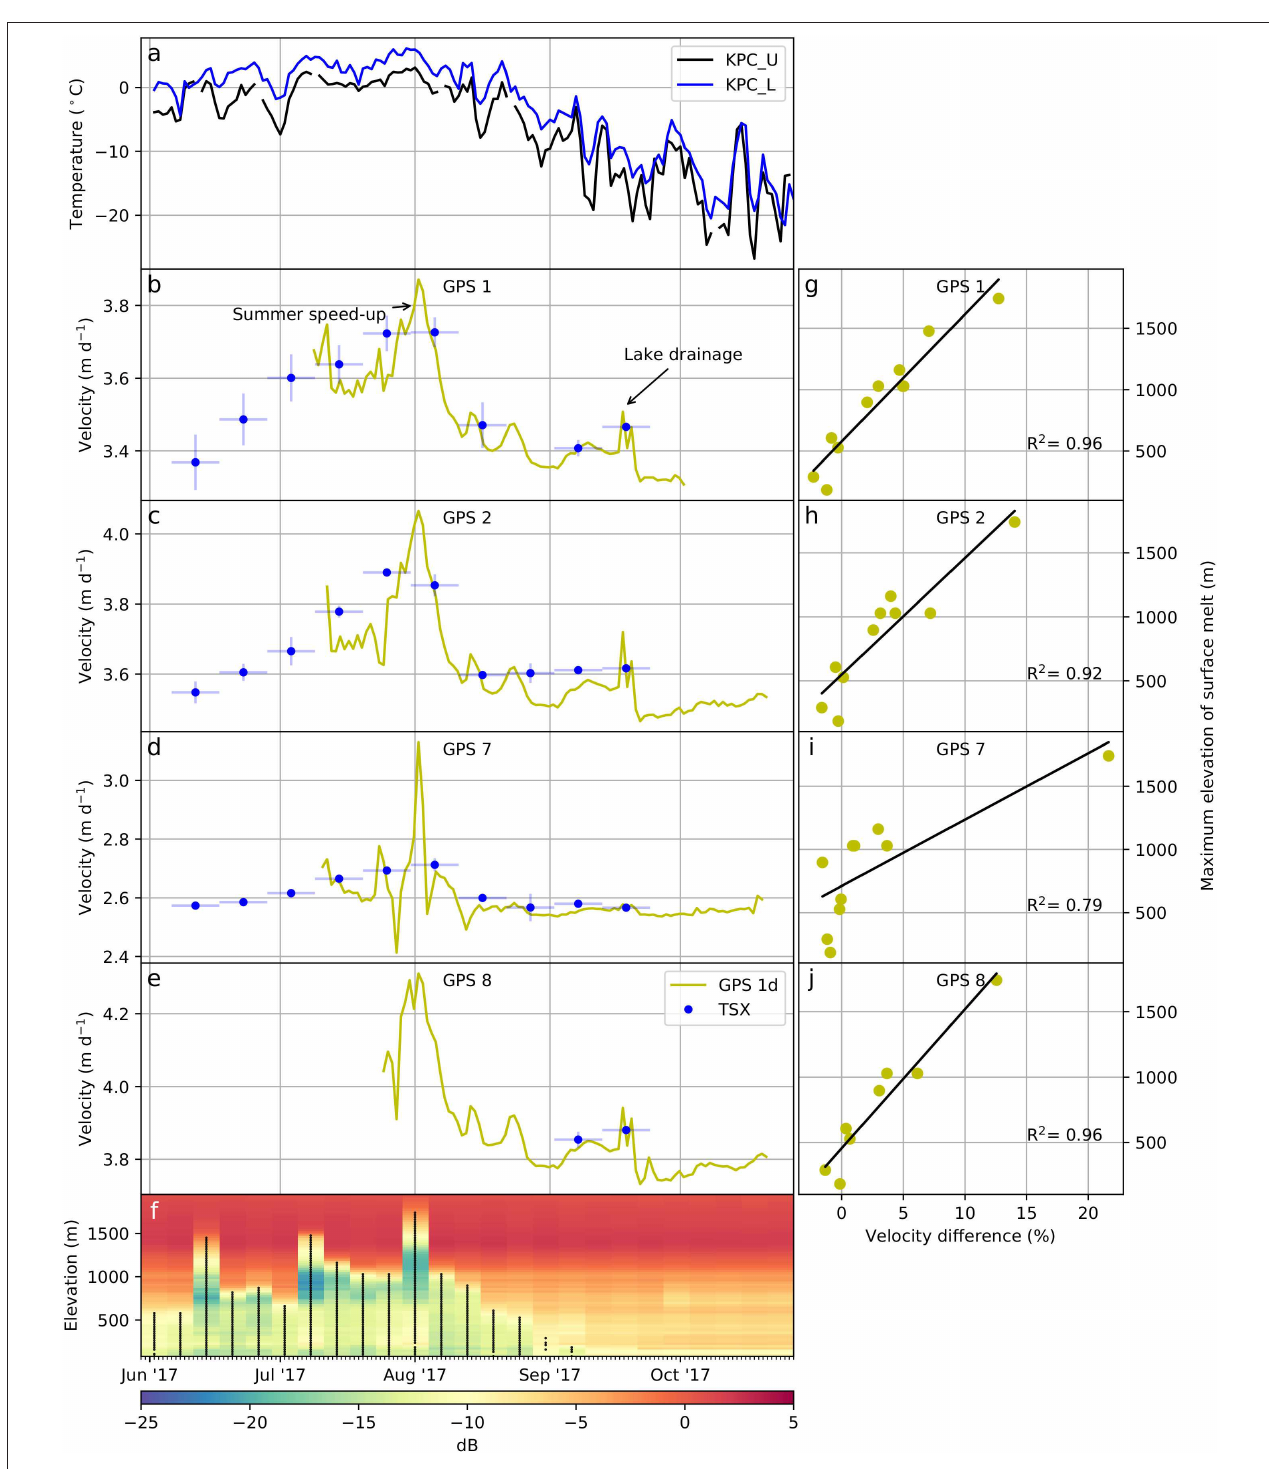
FIGURE 3 | Relation between near surface air temperature measured at PROMICE AWS KPC_U and KPC_L (a) (Fausto and van As, 2019), horizontal surface velocities as measured at the four GPS sites indicated in Figure 1 (b–e) and surface melt estimates from the Sentinel-1 time series shown in Figure 2b (f) . TerraSAR-X derived surface velocities are centered at the mean date between data acquisitions with light blue bars in x-direction indicating the 11-day period between the dates of data acquisition. Light blue bars in y-direction represent the weighted standard deviation of the pixel values employed in the interpolation of the shown velocity estimates. GPS estimates are averaged over one day. Note the different data ranges in (b–e) . Scatter plots (g–j) show the relation between GPS measured surface velocities relative to a TerraSAR-X derived winter velocity field and the maximum elevation of surface melt from the Sentinel-1 time series shown in Figure 2b and (f) .